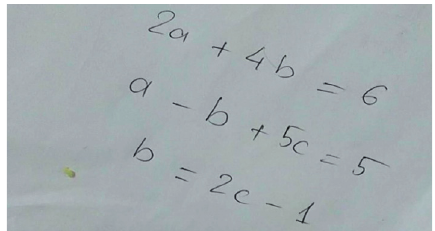
Figure 6: An example of input image.